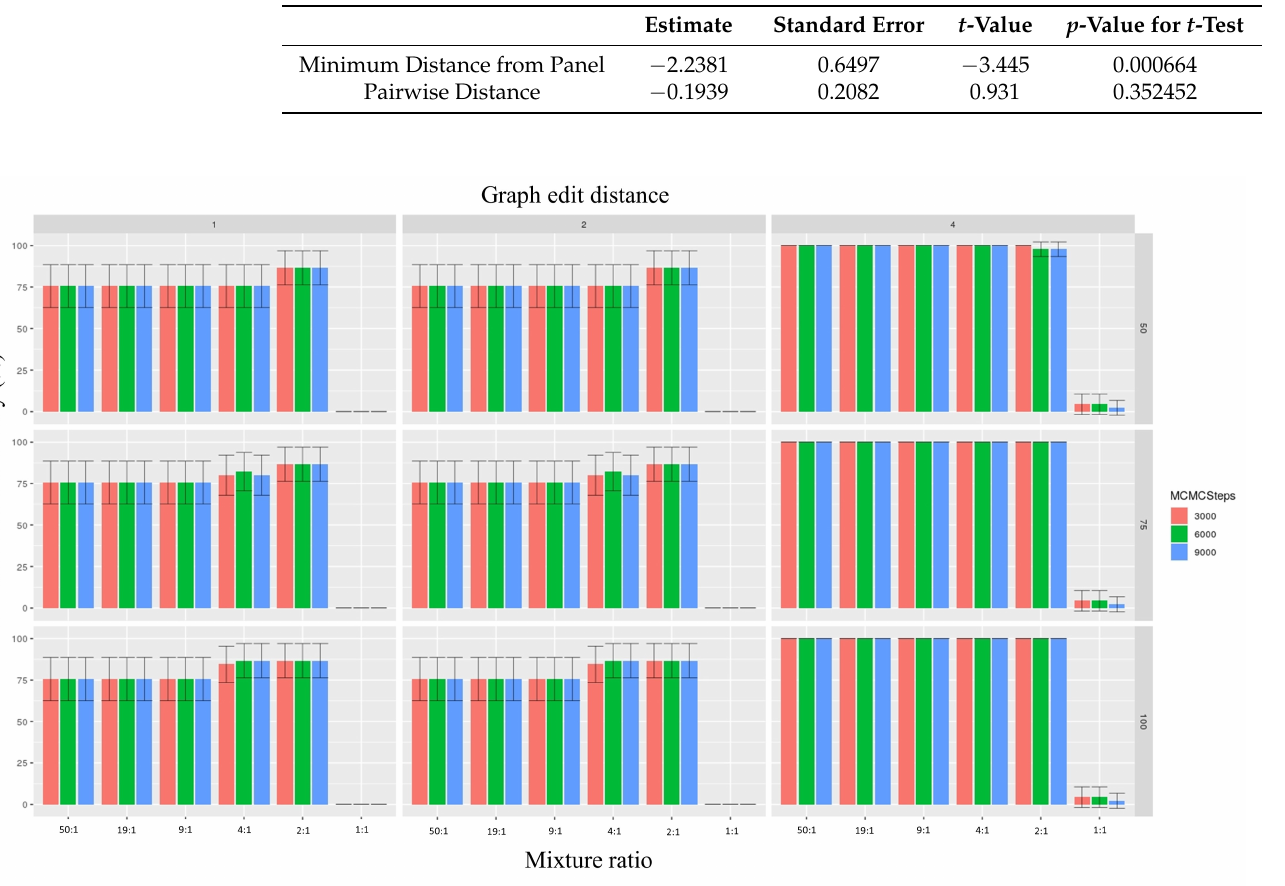
Figure 5. Histograms depicting the percent accuracy of phasing mixtures (both minor and major contributors) correctly resulting from simulations based on different parameter values. The x-axis represents the mixture ratios, the y-axis represents accuracy, and the colors of the bars represent the number of Markov Chain Monte Carlo (MCMC) steps. Each column represents a graph edit distance, while each row represents read counts. The vertical crossbars represent 95% confidence intervals. For descriptions of parameter values, please refer to the Materials and Methods